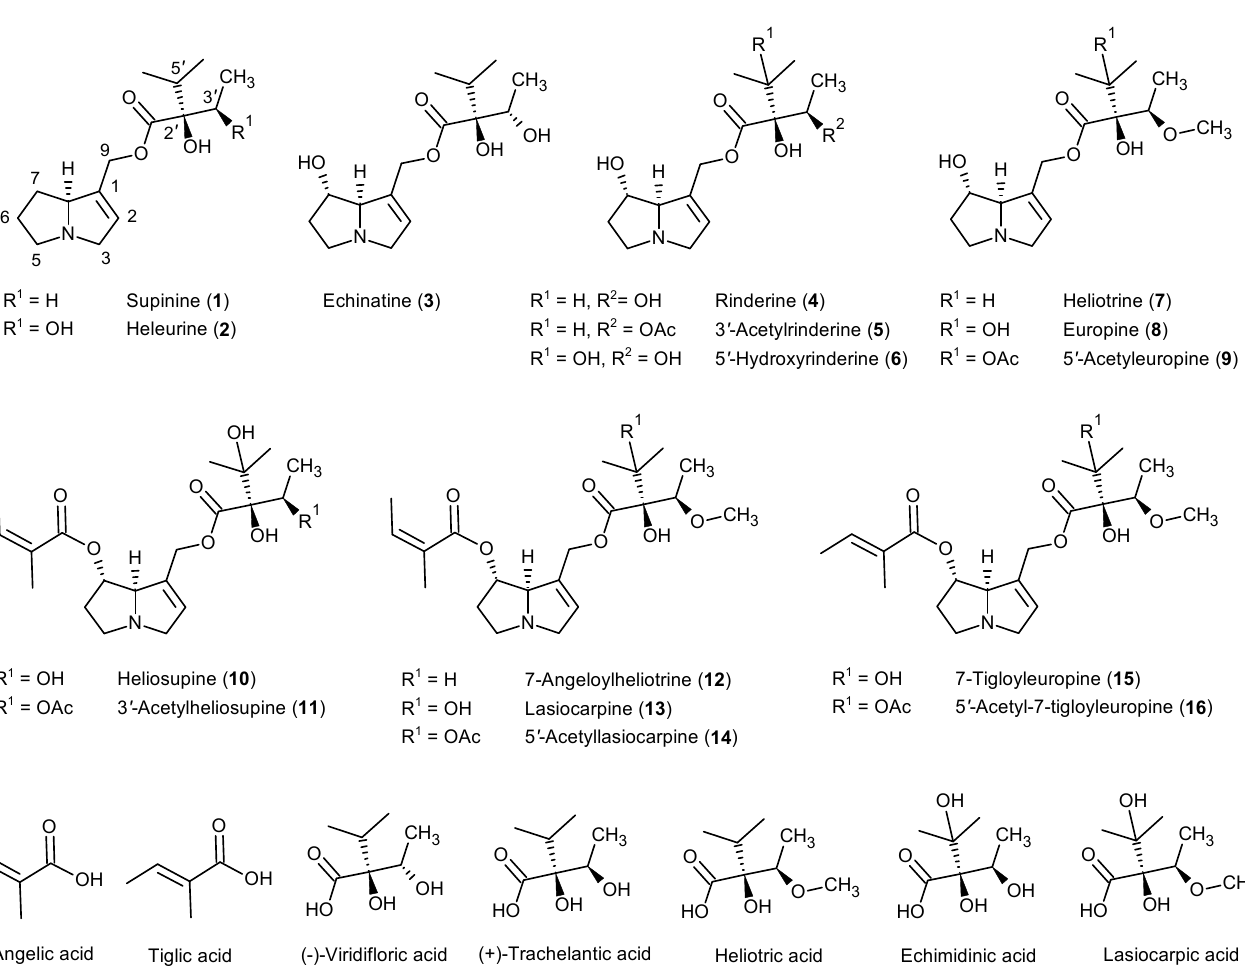
Figure 1. Pyrrolizidine alkaloids (PAs) and corresponding necic acids commonly found in Heliotropium species. The corresponding PA- N -oxide forms are not shown.